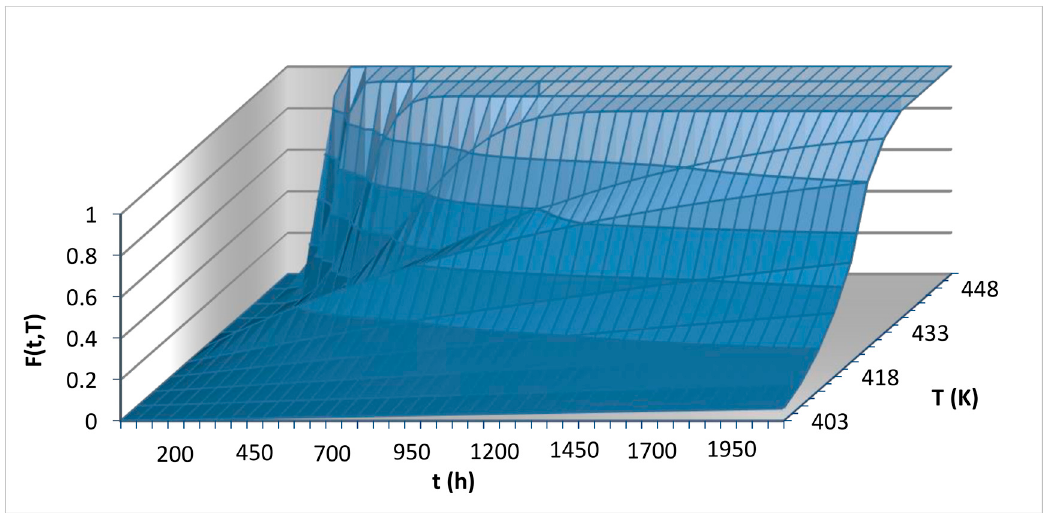
Figure 12. 3D plot of estimations of the distribution functions of the Weibull distribution depending on temperature for the proposed probabilistic model.